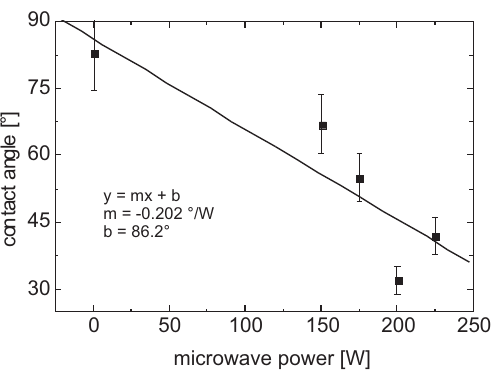
Figure 23. Contact angle of films of parylene N against water. With rising microwave power, the films become increasingly hydrophilic in character.